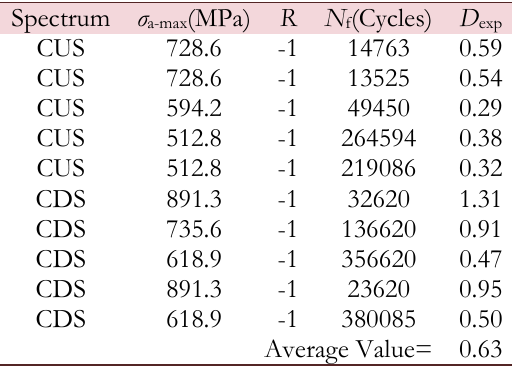
Table 5: Summary of the experimental results generated by testing the plain samples under fully-reversed VA loading and experimental values of the critical damage sum, D cr